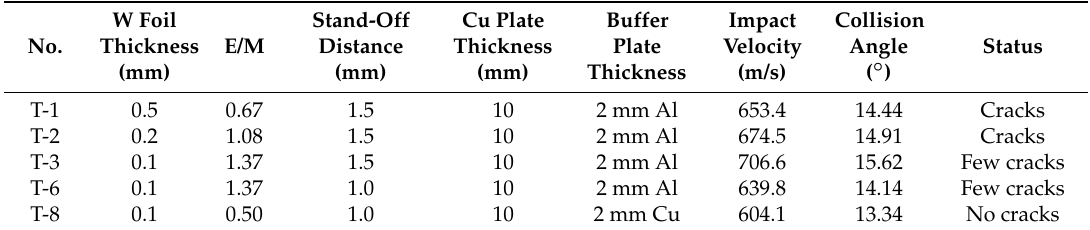
Table 1. Dynamic parameters of welding.